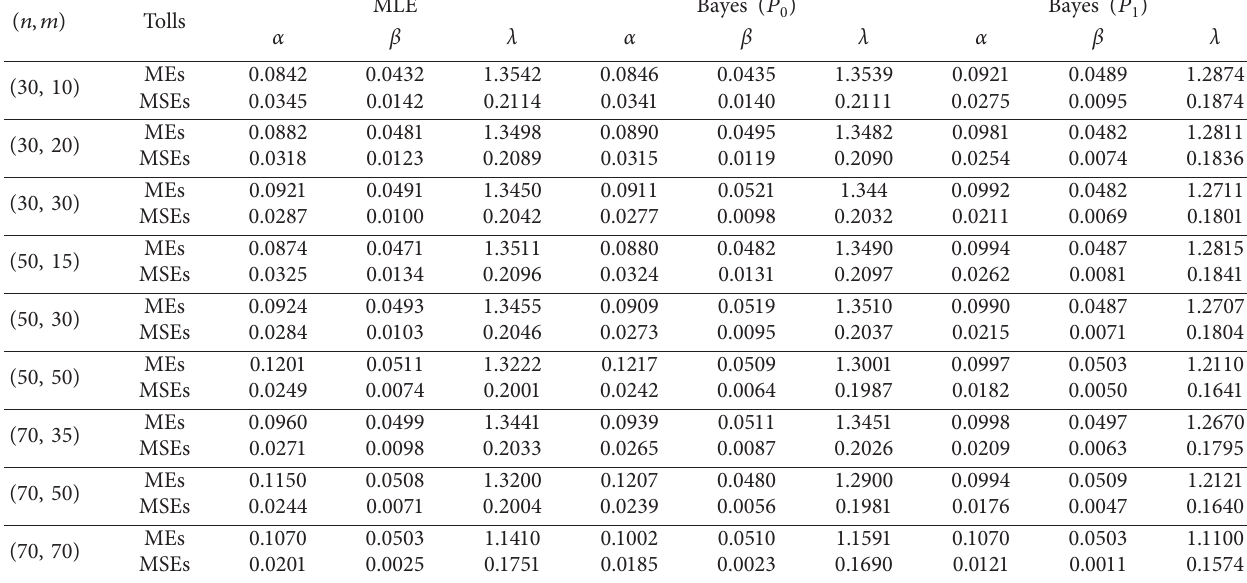
Table 6: MEs and MSEs from ω � 0 . 1 , 0 . 05 , 1 . 0 { } .